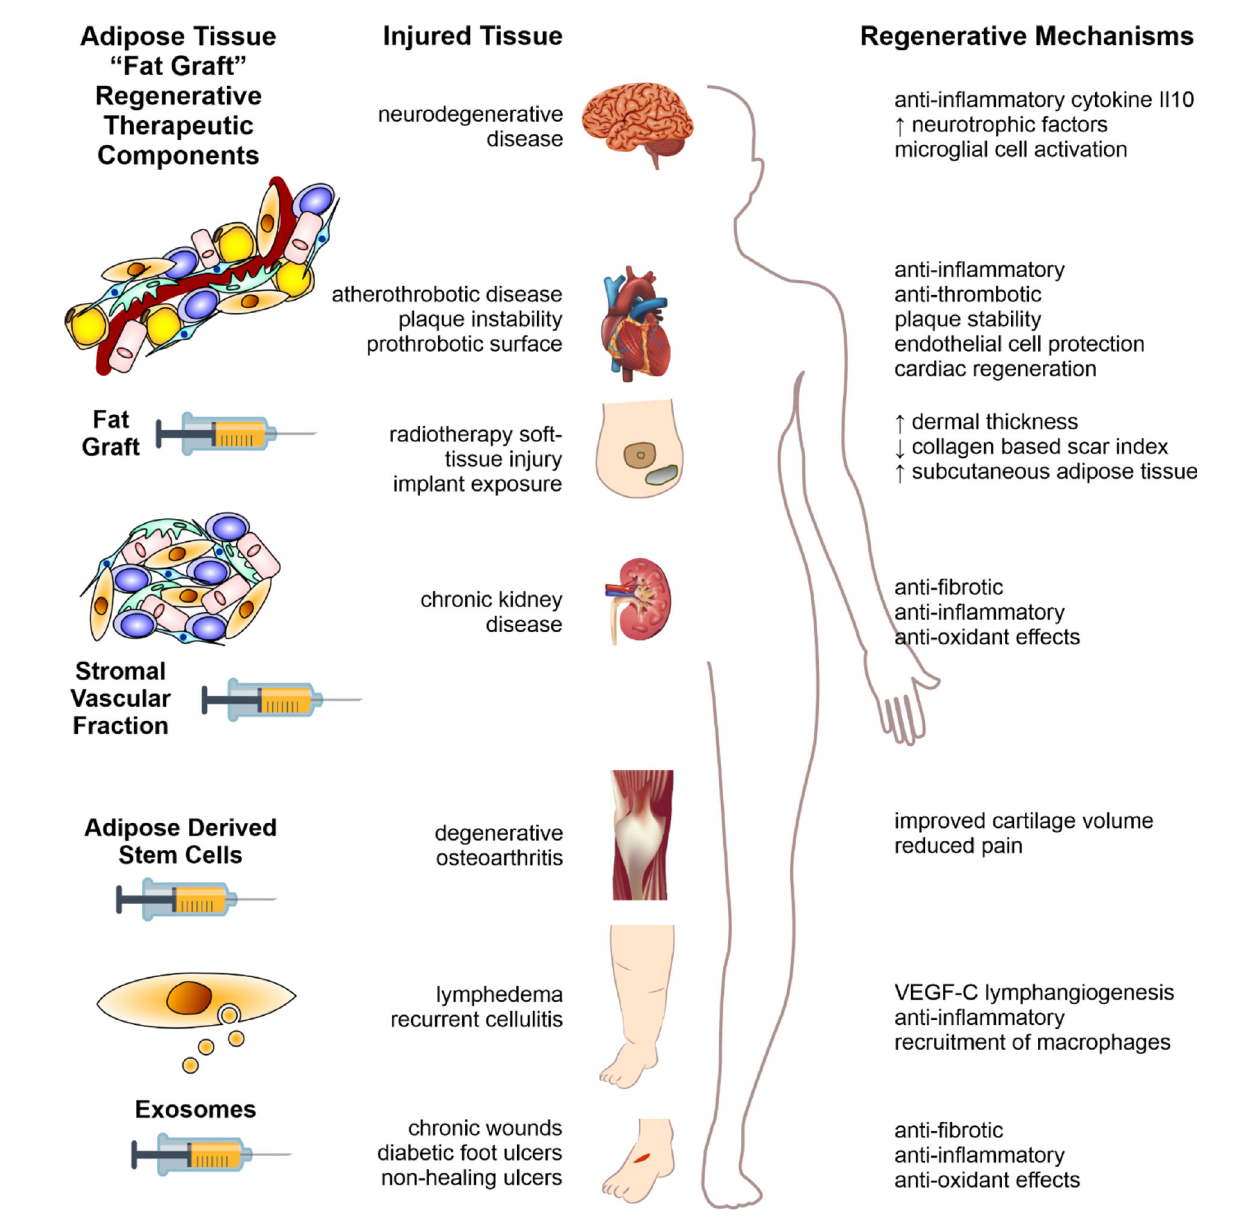
FIGURE 2 | Fat therapeutics of adipose tissue in human disease. Schematic summary of adipose tissue “ fat graft ” obtained via liposuction of subcutaneous fat. Re fi nement of this fat graft can has occurred at various levels from the acquisition of the rudimentary fat graft, further processed with digestion to obtain the stromal vascular fraction cell pellet, further re fi nement with extraction of ADSCs, and extracellular vesicle isolation (left column). Each of these components demonstrate signi fi cant therapeutic potential in reversing the pathology of human disease, across a range of body systems (middle column). The mechanisms by which these effects are mediated are illustrated in the right-hand column. Figure adapted from Shukla et al. (2015) under the CC-BY license (Shukla et al.,